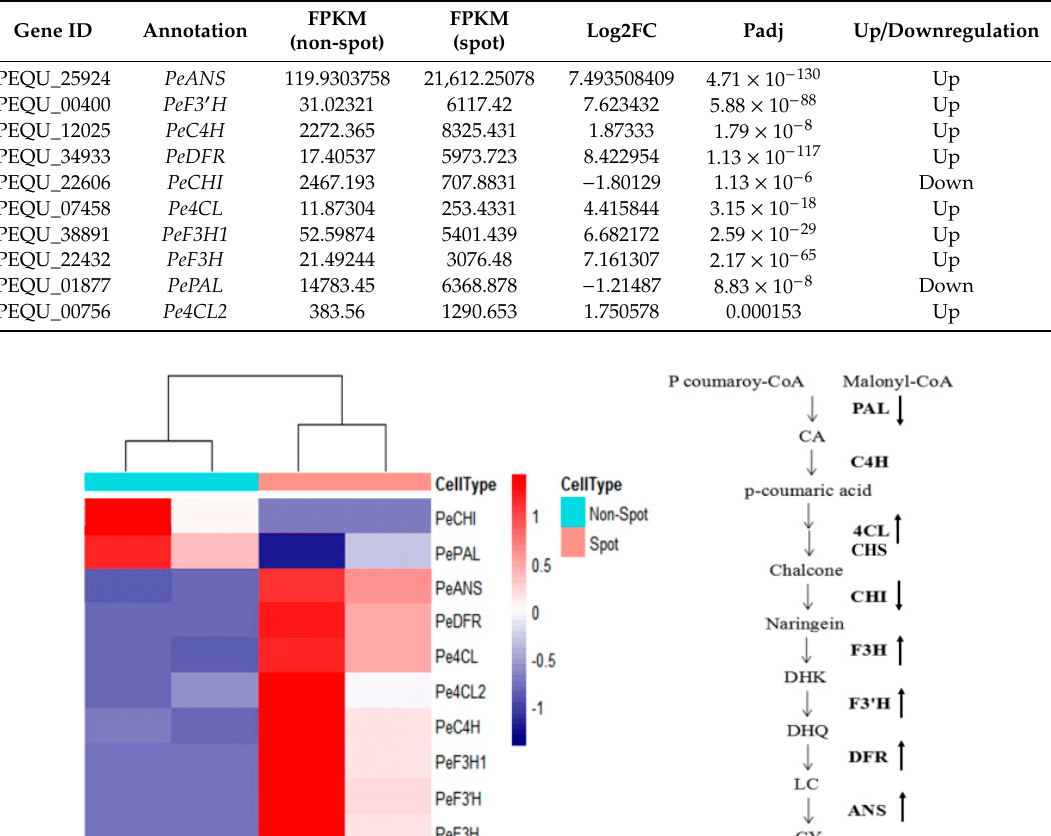
Figure4. Heatmapofdi ff erentiallyexpressedstructuregenes(DEGs)relatedtoanthocyaninbiosynthesis Figure 4. Heatmap of differentially expressed structure genes (DEGs) related to anthocyanin in Phalaenopsis . Bold arrow means up / downregulations of genes. (PAL, phenylalanine ammonia lyase; biosynthesis in Phalaenopsis . Bold arrow means up/downregulations of genes. (PAL, phenylalanine C4H, cinnamate-4-hydroxylase; 4CL, 4-coumarate–CoA ligase; CHS, chalcone synthase; CHI, chalcone ammonia lyase; C4H, cinnamate-4-hydroxylase; 4CL, 4-coumarate--CoA ligase; CHS, chalcone isomerase; F3H, flavanone 3-hydroxylase; F3 (cid:48) H, Flavonoid 3’-hydroxylase; DFR, dihydroflavonol synthase; CHI, chalcone isomerase; F3H, flavanone 3-hydroxylase; F3 ′ H, Flavonoid 3’-hydroxylase; 4-reductase; ANS, Anthocyanidin synthase; DHK, dihydrokaempferol; DHQ, dihydroquercetin; DHM, dihydromyricetin; LC, leucocyanidin; Cy,